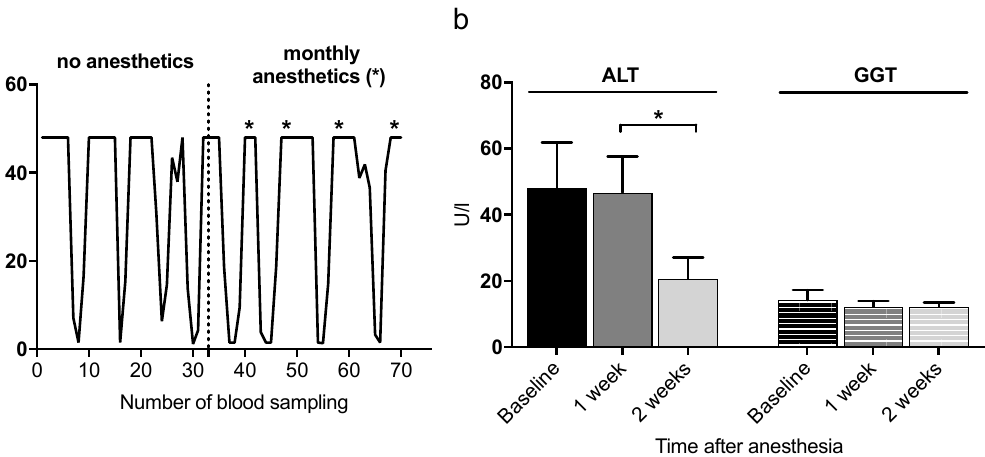
Figure 1. Repeated anesthesia neither impairs reproductive cycles nor hepatic health, as displayed by alanine aminotransferase (ALT) and gamma-glutamyl transferase (GGT) concentrations. ( a ) Representative progesterone profile of a marmoset before and during monthly anesthesia with ketamine, xylazine, and atropine. No general changes in the progesterone profiles were encountered after initiation of monthly anesthesia. ( b ) Liver enzymes ALT and GGT in serum samples before as well as 1 and 2 weeks after anesthesia as markers for hepatic health ( n = 4). Both enzymes remained in the normal range of healthy marmosets at all time points. Bars represent mean ± SEM. * p < 0.05.